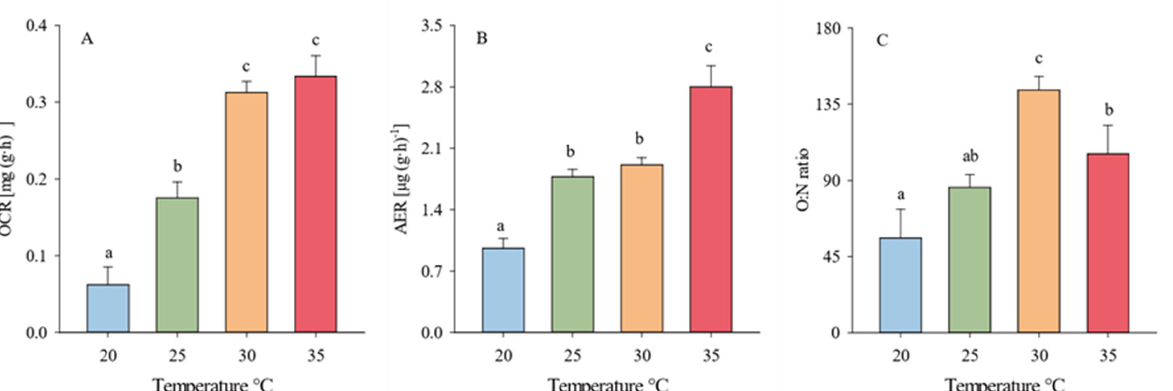
Figure 5. The content of ecdysone ( A ) in the hemolymph. Expression of the molting-related gene ( ecr ) ( B ) and molt-inhibiting hormone ( mih ) ( C ) in eyestalks. Values are presented as mean ± SD ( n = 3). Different superscripts indicate significant differences between treatments ( p < 0.05).